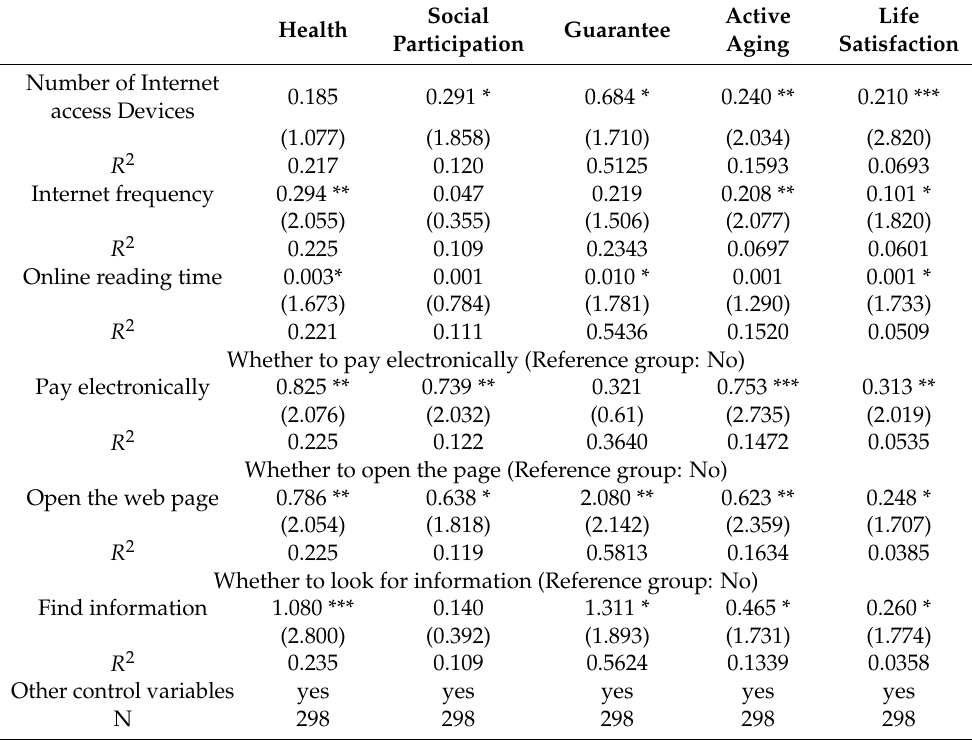
Other control variables yes yes yes yes